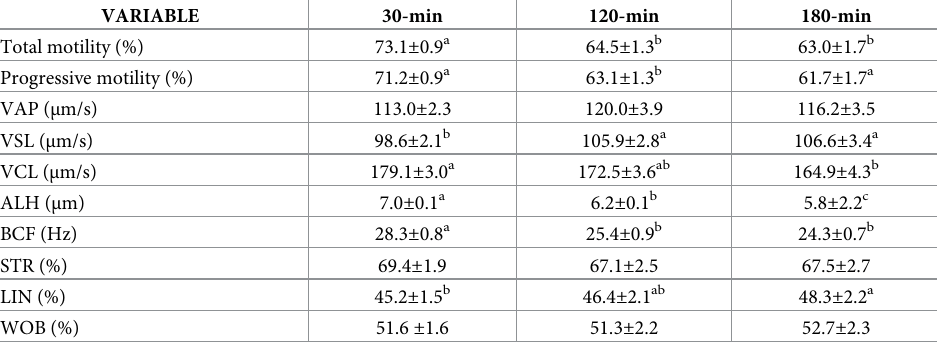
Table 3. Effect of incubation time (all experimental groups combined) on sperm motion parameters assessed via CASA after 30-min, 120-min, and 180-min incubation in TALP medium (LS mean ± SEM).